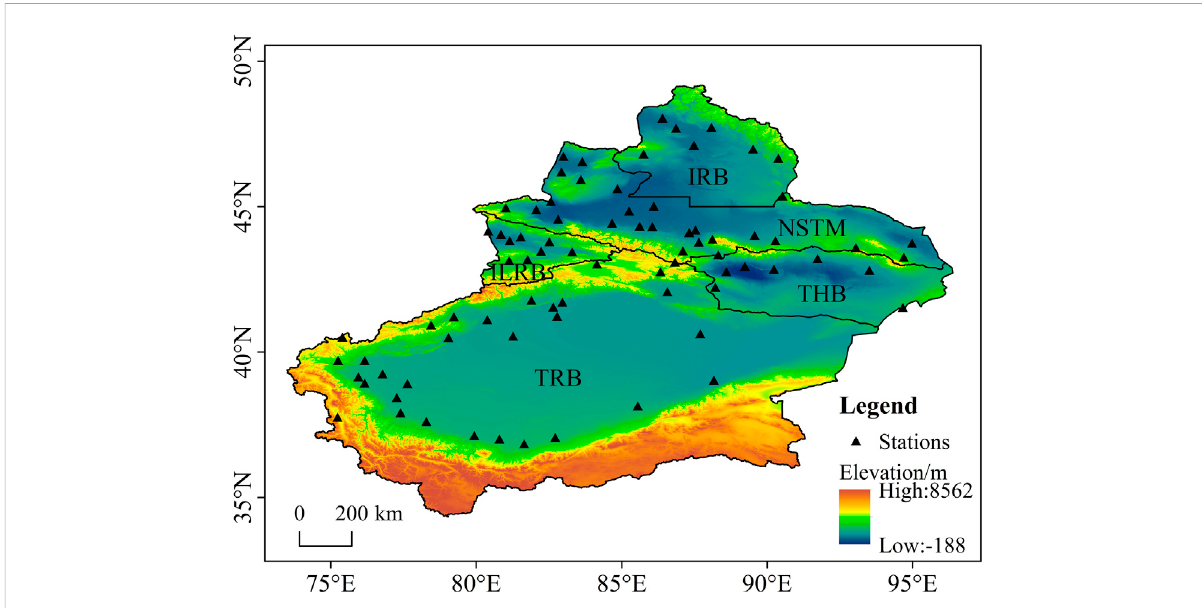
FIGURE 1 Study area and the distribution of meteorological stations. (The Irtysh River Basin, the economic belt on the northern slope of the Tianshan Mountains, the Ili River Basin, the Turpan-Hami Basin, and the Tarim River Basin are marked as IRB, NSTM, ILRB, THB, and TRB,